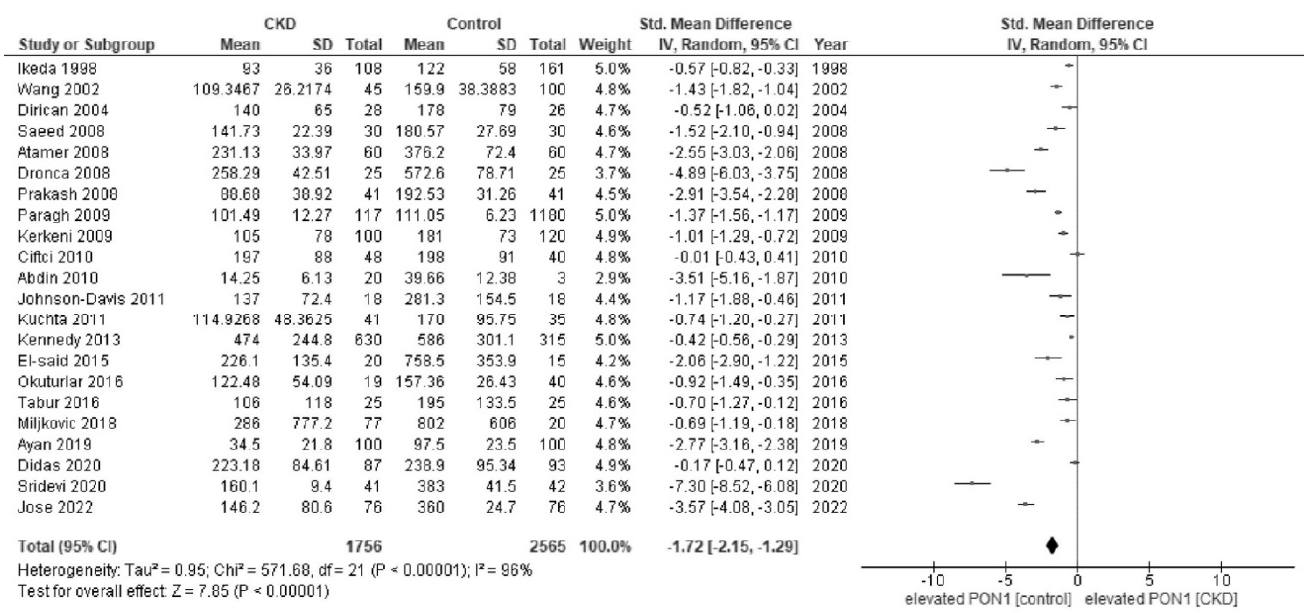
Figure 2. Forest plot of paraoxonase activity in all studies [26–42,44,46–49].